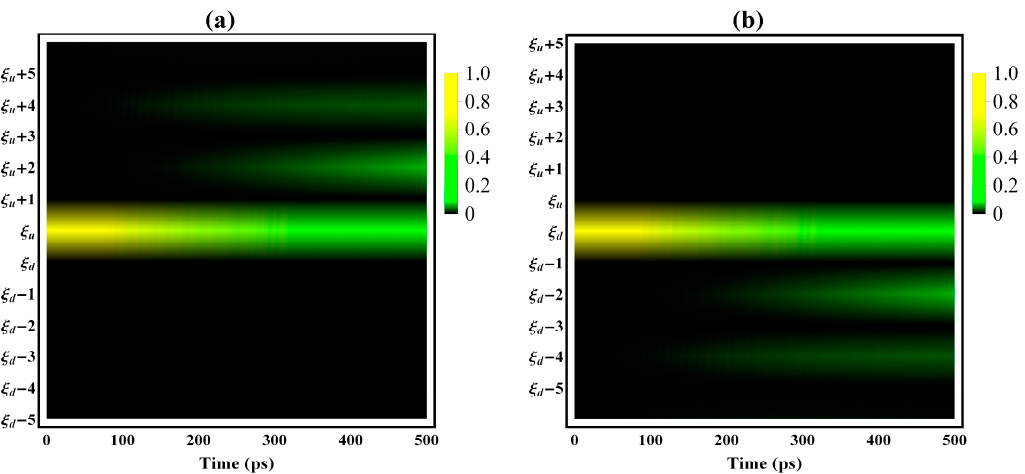
Figure 6. Time evolution of the probability distribution of the exciton over ( a ) molecular orbitals above the gap and the localized orbital | ξ u (cid:105) ; and ( b ) molecular orbitals below the gap and the localized molecular orbital | ξ d (cid:105) .